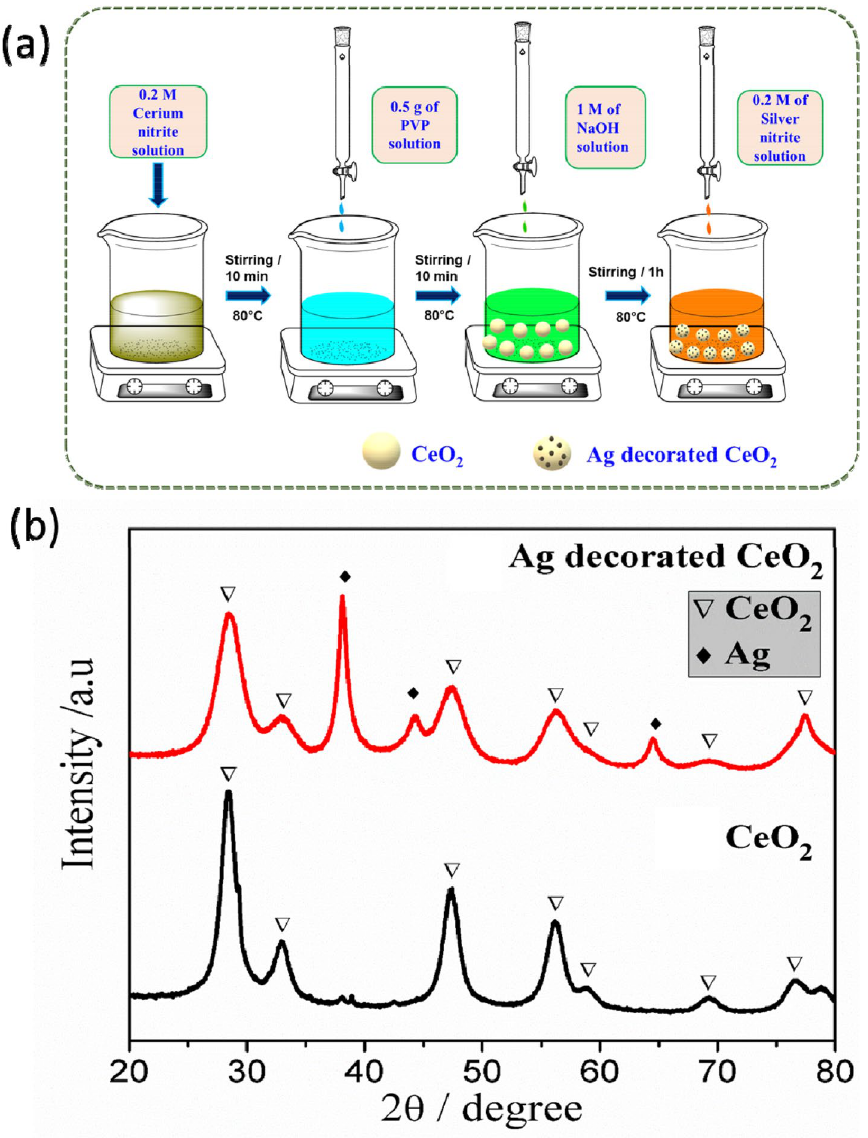
2 and Ag decorated CeO 2 nanoparticles. The asterisks (•) and (∆) are represents corresponds to pure CeO 2 and Ag and CeO 2 characteristic diffraction